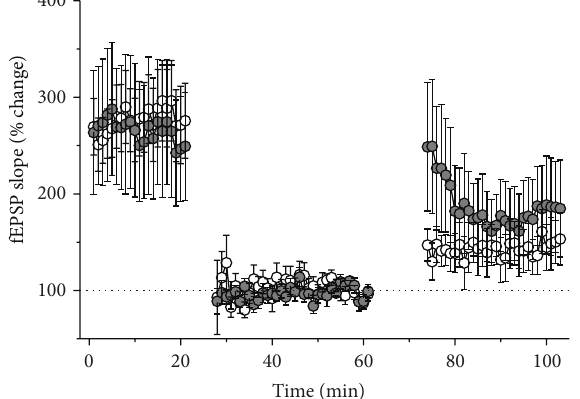
Figure 6: Synaptic depotentiation restores LTP in NADNA-pretreated slices to the control level. Pretreatment of slices with NADNA did not affect LTD of fEPSP evoked by LFS stimulation. Thirty min after the induction of LTD, tetanic stimulation of the Shaffer collaterals induces a similar potentiation of the field potential responses in NADNA-pretreated and control slices. All data are presented as Mean ± SE.